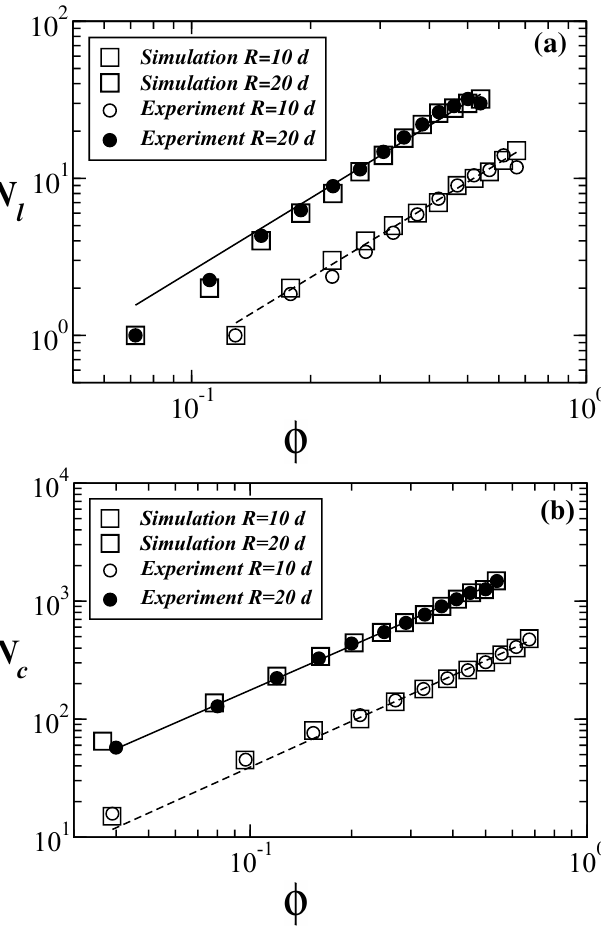
of contacts N c as a function of the packing fraction φ . The open and full symbols correspond to a cavity of radius R = 10 d and R = 20 d , respectively. The solid and dashed lines correspond to least-squares fits to the data, giving the scaling exponents α = 1 . 72 ± 0 . 06 for loops ( a ) and β = 1 . 19 ± 0 . 03 for contacts ( b